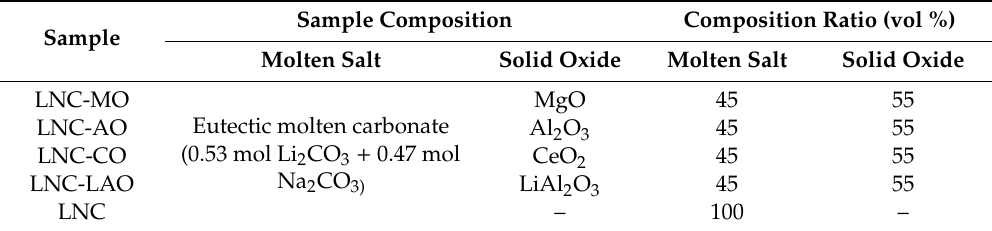
Table 1. The composition of the samples used in the